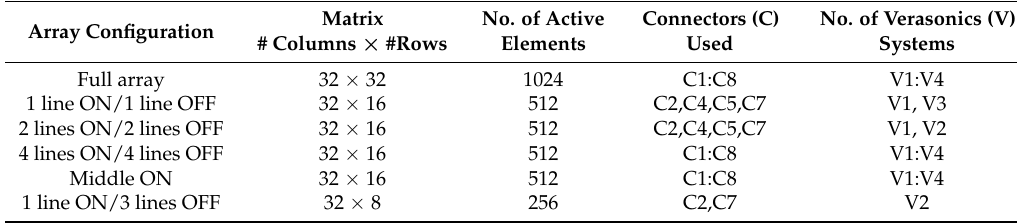
Table 2. US probe matrix configurations and Verasonics combinations.